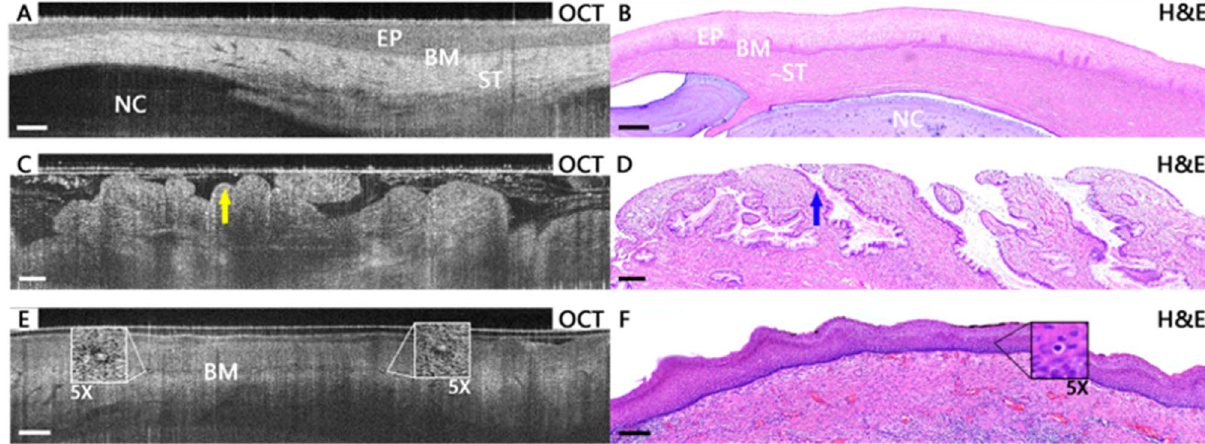
Figure 3. Typical OCT images and corresponding H&E histological images of low-risk cervical tissues. In ( A ) and ( B ), a Nabothian cyst of inflammation tissue can be observed under the stroma layer. In cervical columnar epithelial ectropion tissue, the papillary structure with hyper-scattering boundaries is visible in the OCT image ( C ), which is consistent with the single-layered columnar cells in the H&E section ( D ). In an LSIL tissue, koilocytotic cells are clearly visible at additional 5 × magnification in OCT image ( E ) and H&E section ( F ). Scale bars 200 μm. H&E magnification: 10 ×.